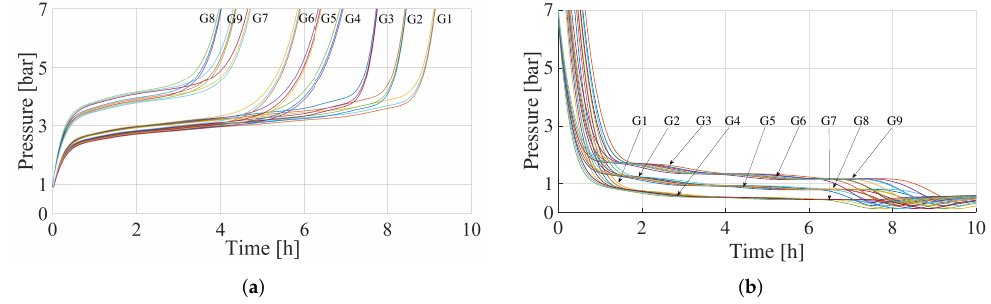
Figure 9. Pressure as a function of time: ( a ) Absorption process, ( b ) Desorption process.